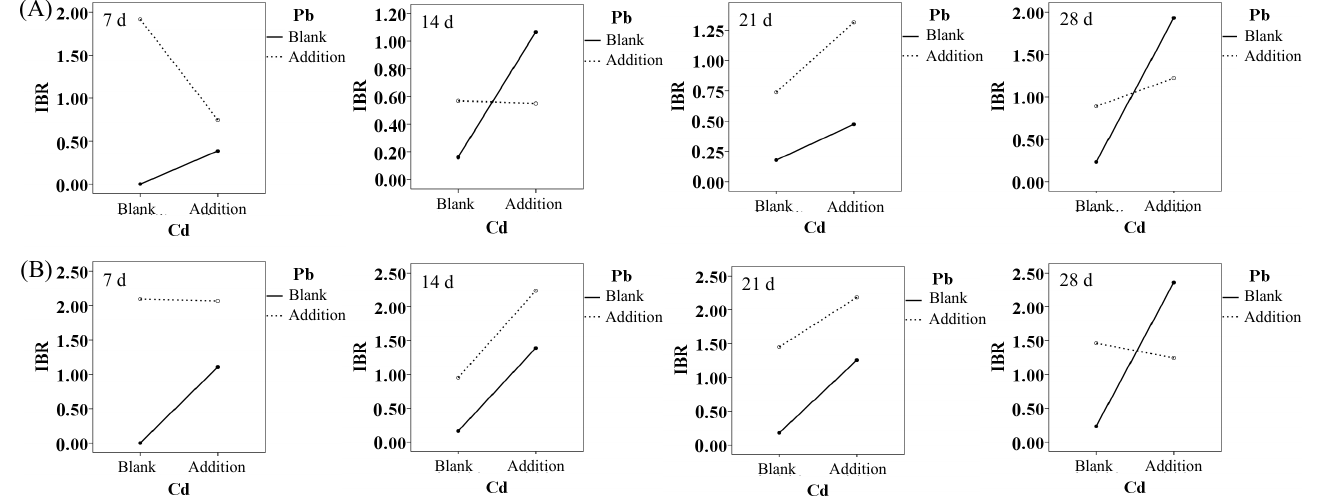
Figure 5. The interaction effects of Cd and Pb in waters at ambient concentrations ( A ): 0.01 mg/L, ( B ): 0.10 mg/L) on hepatopancreas of M. nipponense after exposure for 7, 14, 21 and 28